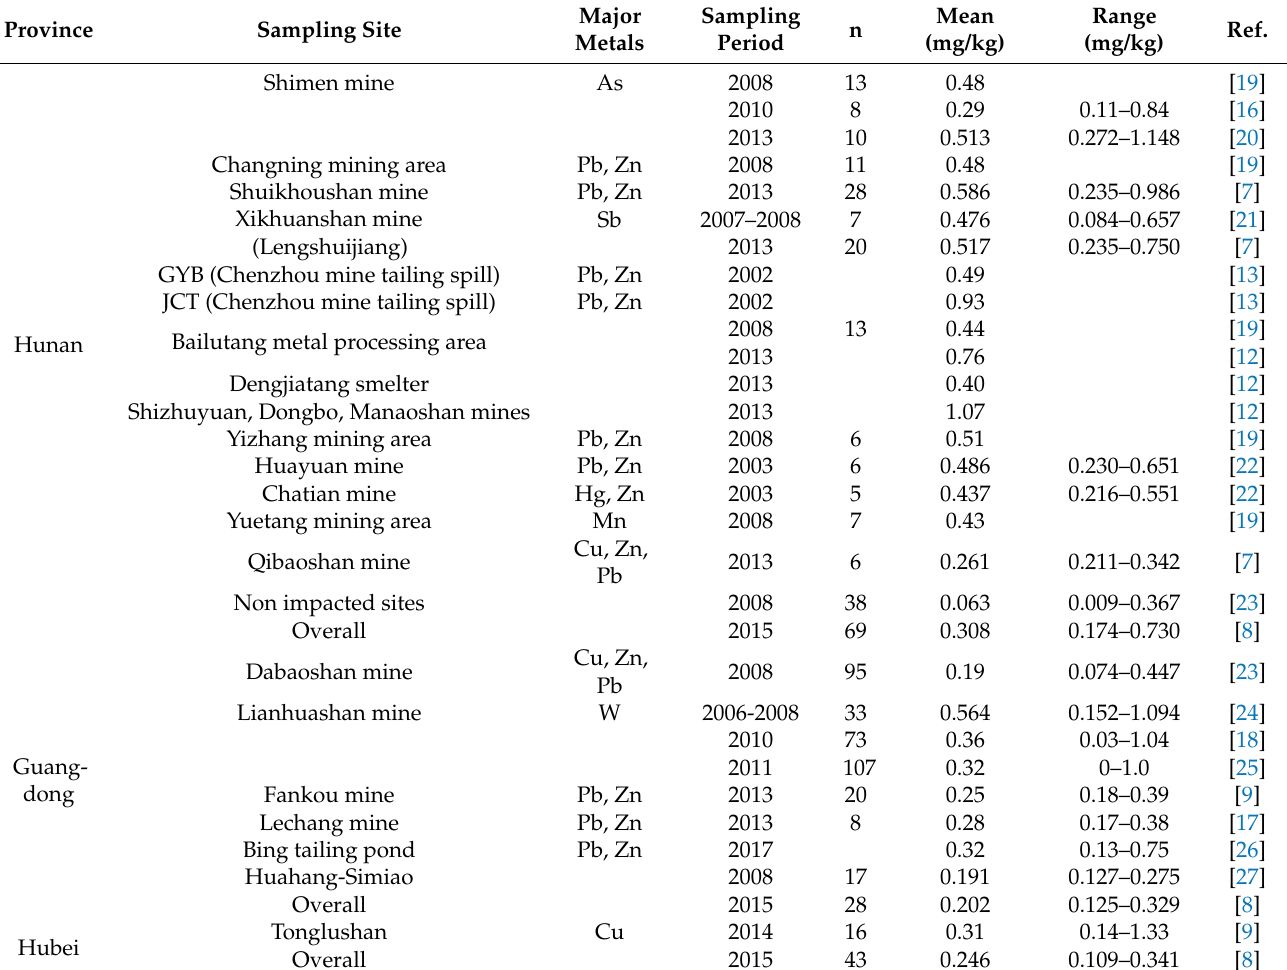
Table 1. Total arsenic concentration in husked rice sampled from mining areas in